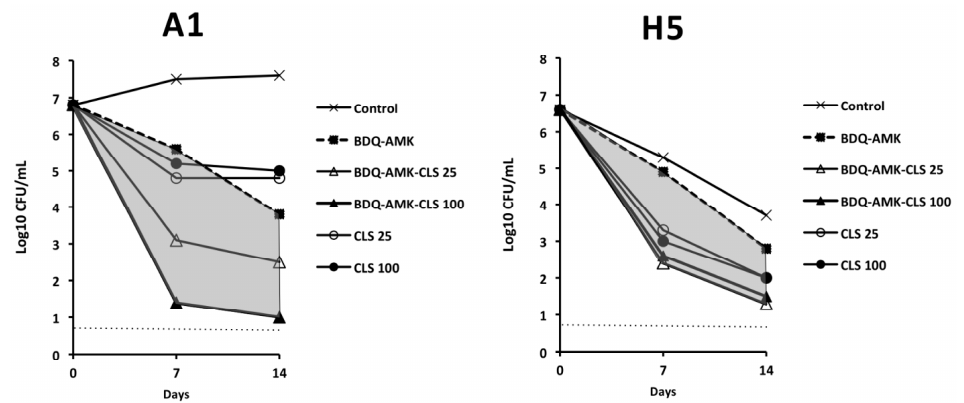
Figure 9. Activity against A1 and H5 cells of 3-drug combinations containing bedaquiline-amikacin (BDQ-AMK) ± 25 µg/mL or 100 µg/mL of colistin (CLS). Increases in the activities of BDQ-AMK-CLS versus BDQ-AMK are highlighted in grey. Dashed lines indicate the limit of detection (5 CFU/mL). Furthermore, BDQ-AMK-RFB-CLR-MTR-CLS 100 decreased A1 and H5 CFU more efficiently than BDQ-AMK-RFB-CLR-MTR (Figure 10) and, unlike BDQ-AMK-RFB-CLR- MTR, killed both A1 and H5 cells, as shown by the lack of regrowth in MGIT of A1 cells in 42 days and of H5 cells in 56 days (Table 2). Lower activity against A1 and H5 cells was shown by BDQ-AMK-RFB-CLR-MTR-CLS 25 .